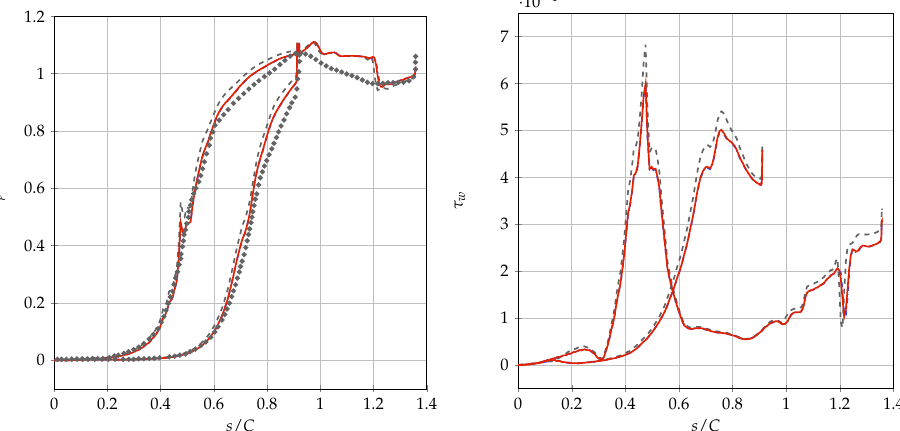
P 2 RANS IG EoS, −